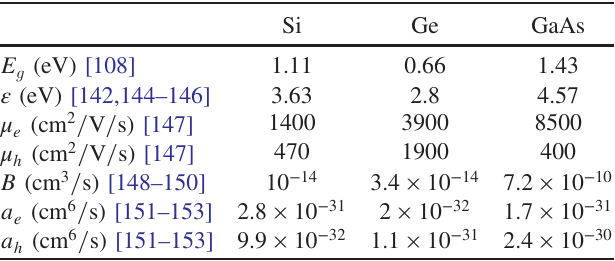
TABLE I. Electronic properties of Si, Ge, and GaAs at room is the band gap, ε the mean temperature and low doping levels. E g ionization energy, μ the electron and hole mobilities, B the e;h radiative recombination coefficient, and a the electron and hole e;h Auger coefficients. For our estimates in SENSEI ’ s Si Skipper CCDs (see Sec. VA), which operate at 135 K, we use ε ¼ 3 . 75 eV